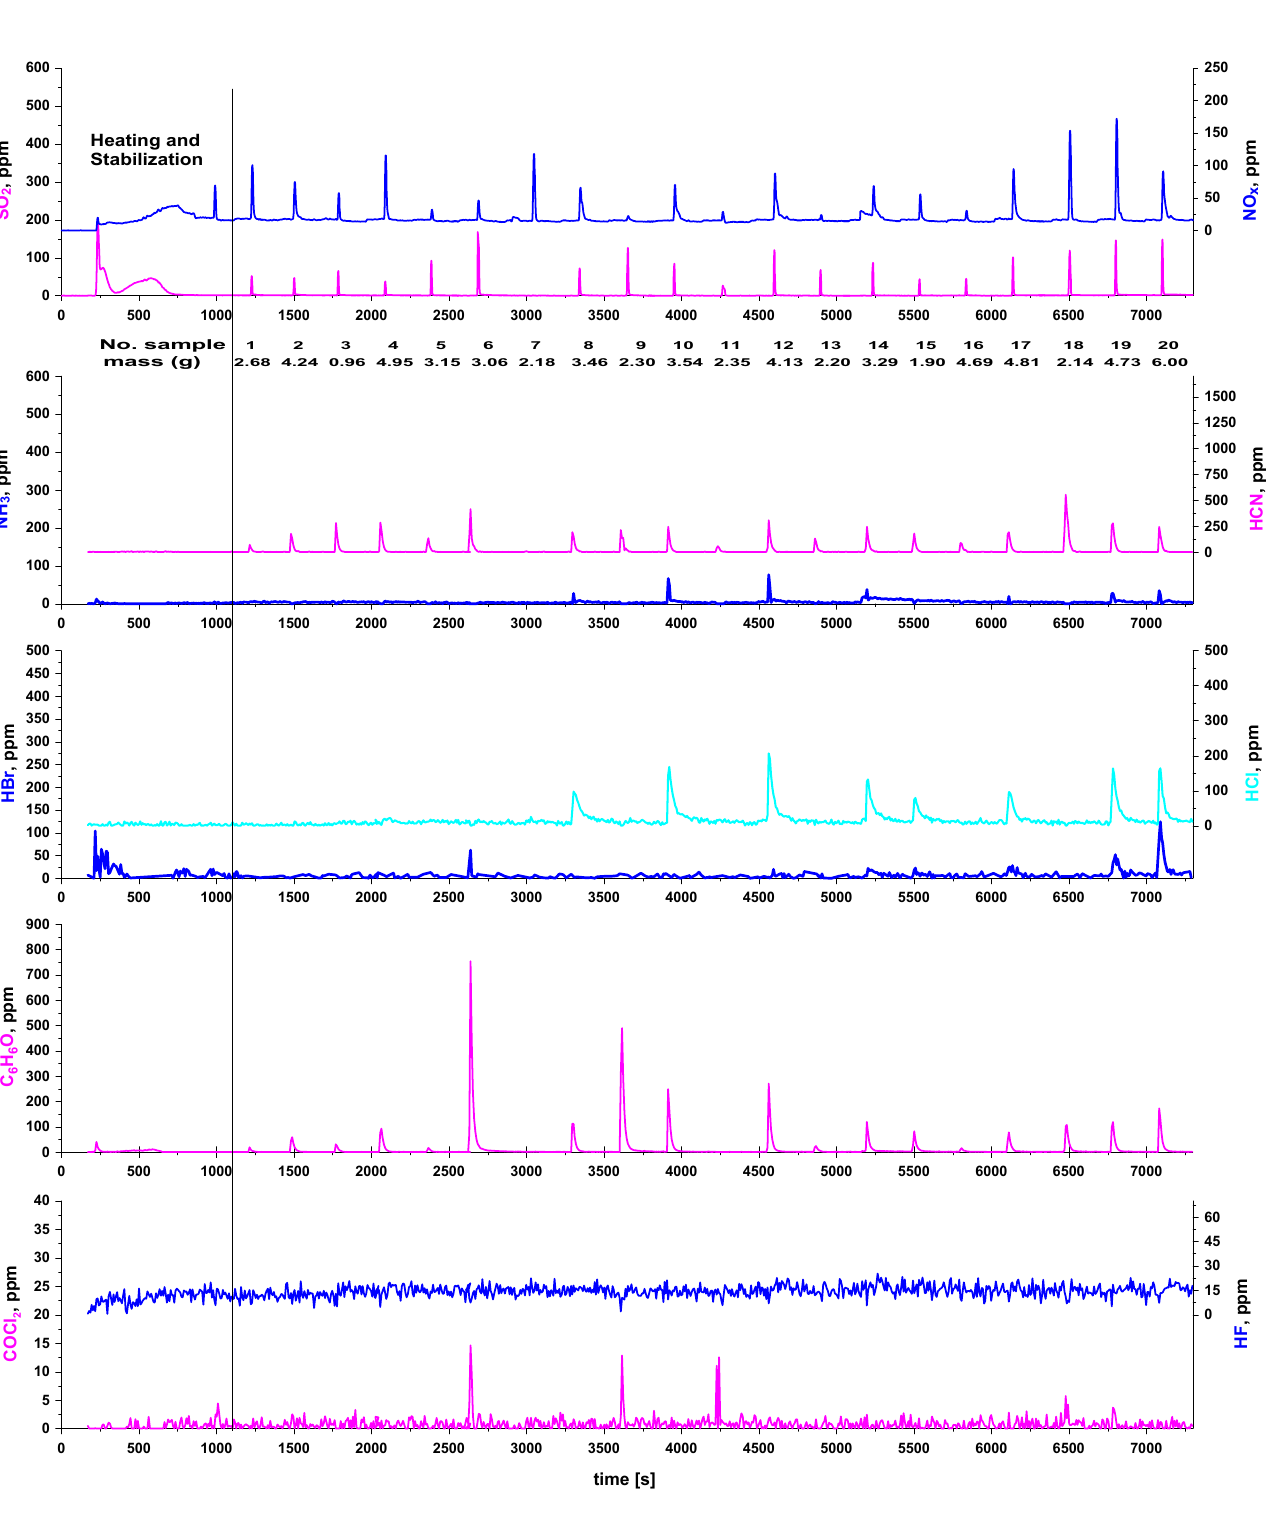
Figure 4. Changes in the concentrations of NO x , SO 2 , HCN, NH 3 , HBr, HCl, HF, C 6 H 6 O and COCl 2 in the exhaust gases generated during thermal treatment of mobile phone waste in a fluidised bed.